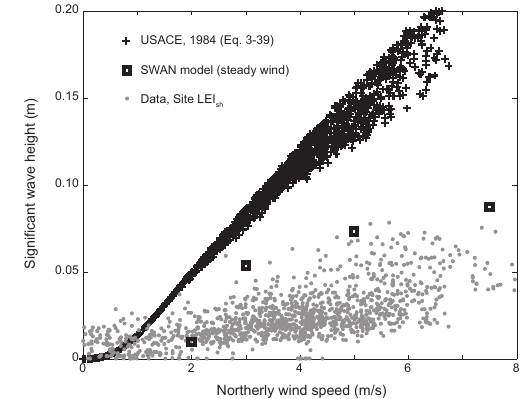
Figure 10. Example of a single day of significant wave height ( H sig ) data from sites LEI chan and LEI sh , and the ratio of 20s win- dow significant wave height ( H sig20 ) to 1200s window significant wave height ( H sig1200 ) . The latter metric is used to identify vessel wakes, which are observed frequently at site LEI chan , but seldom at site LEI sh .